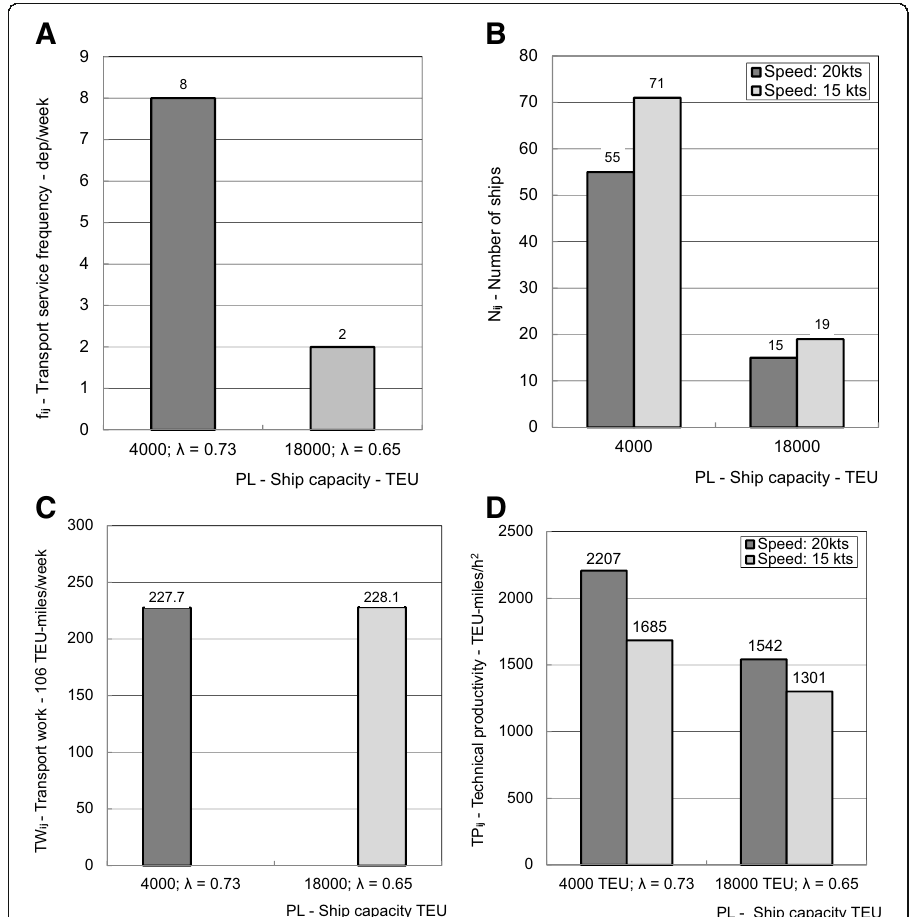
Fig. 9 The indicators of operational performances of the given trunk line/route . a Transport service frequency b Ship fleet size c Transport work d Technical